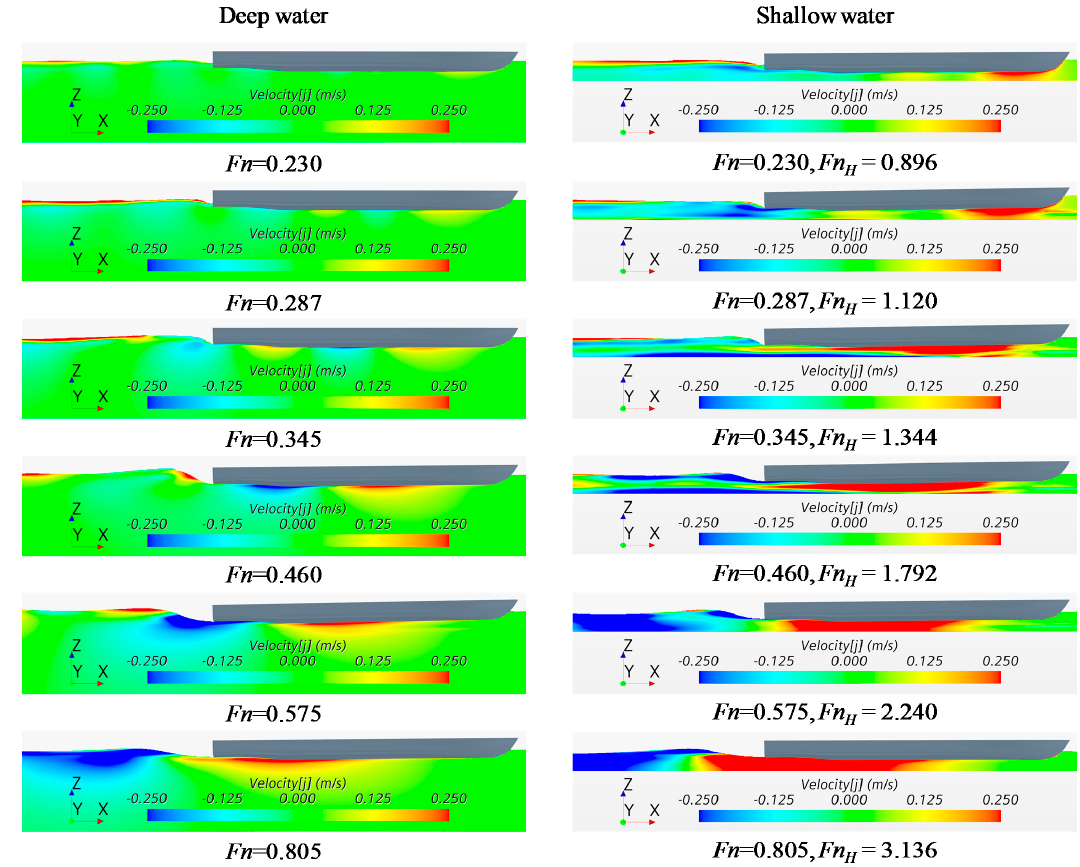
Figure 18. Crossflow fields at the mid-plane of the demihull for deep ( left ) and shallow ( right ) water. Positive and negative velocity values mean the flow moves towards the outer and inner sides of the demihull, respectively.